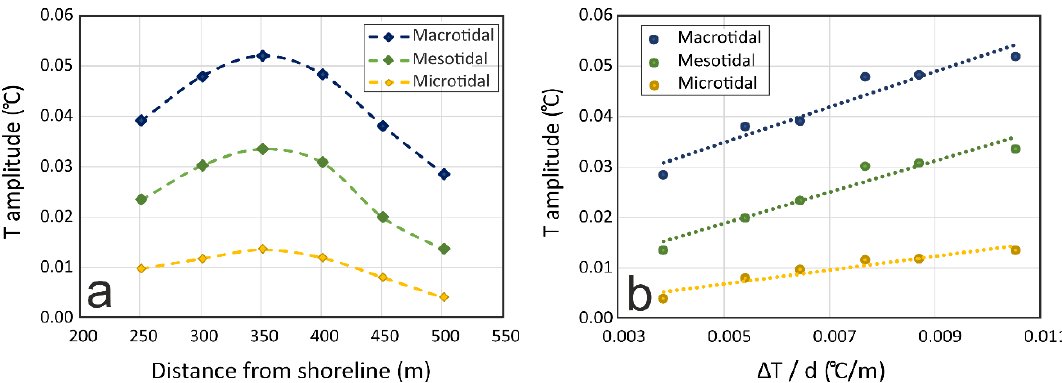
Figure 10. Salinity and temperature distribution resulting from the multilayered model (model B).